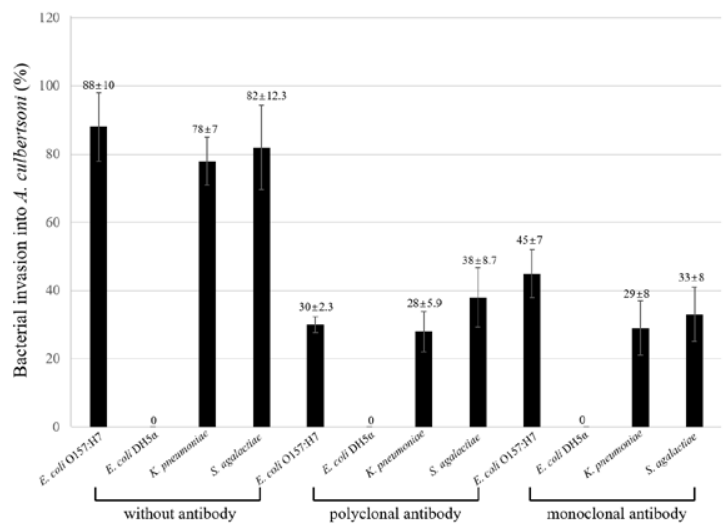
Fig. 2. Percentage of bacterial invasion into A. culbertsoni trophozoites. Pathogenic E. coli O157:H7, K. pnuemoniae, S. agalactiae and one non-pathogenic E. coli DH5 a were analyzed by invasion. Invasion assay was done post to the association assay above. This experiment was performed in triplicate wells with three times, and data were described by mean ± standard deviation (SD)